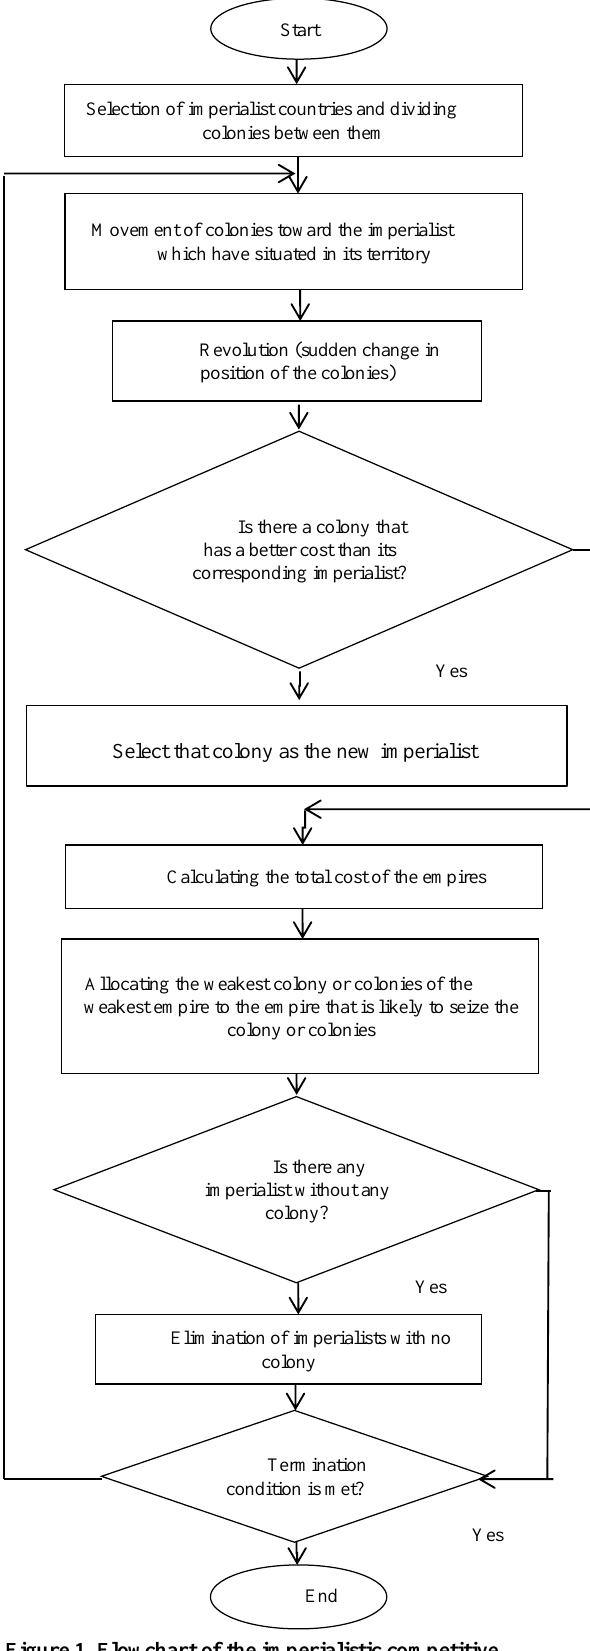
Figure 1. Flowchart of the imperialistic competitive